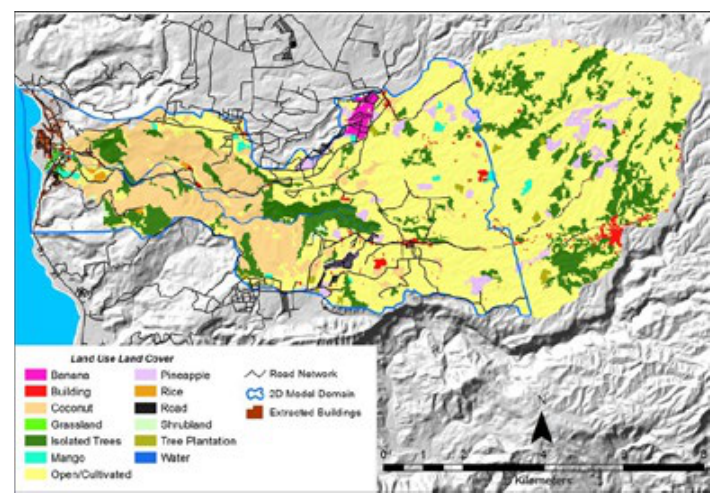
Fig. 3: Land use land cover map of Solana watershed